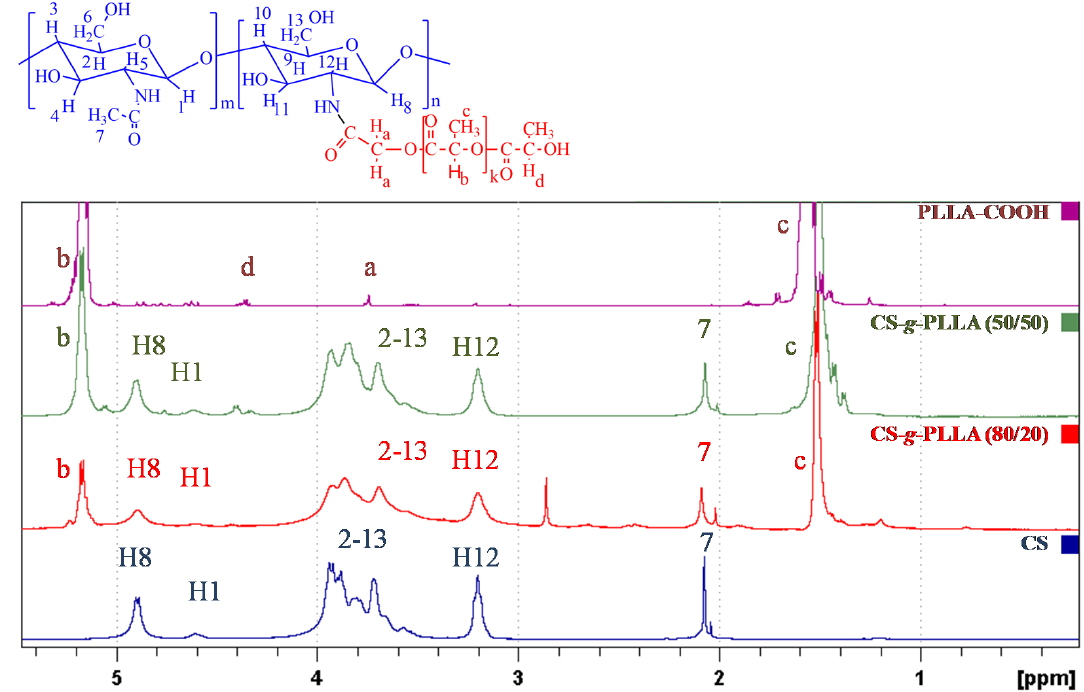
Figure 1. 1 H nuclear magnetic resonance (NMR) spectra of PLLA-COOH in CDCl 3 and CS- g -PLLA(50/50), CS- g -PLLA(80/20) and CS in D 2 O:CF 3 COOD(1:1).